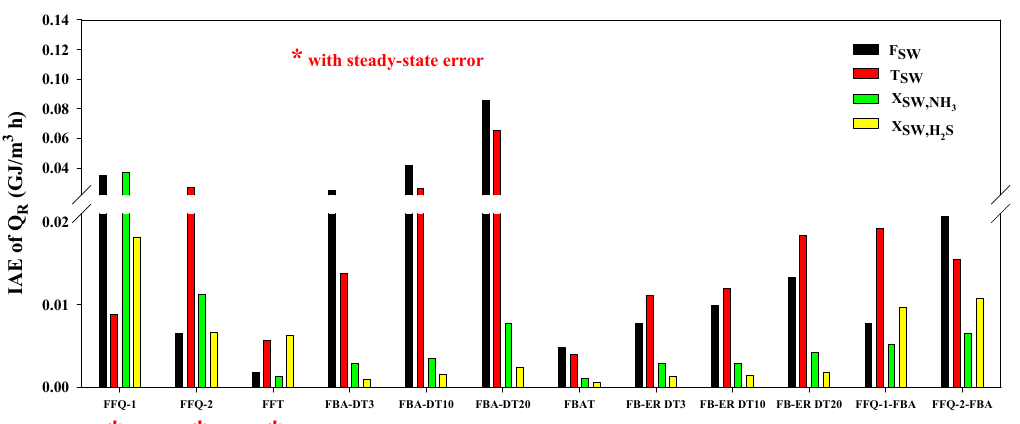
Figure 12. IAE of specific reboiler duty results of all control schemes for the sour water feed stream disturbances, including flowrate, temperature, NH 3 concentration, and H 2 S concentration. (* with steady state offset).